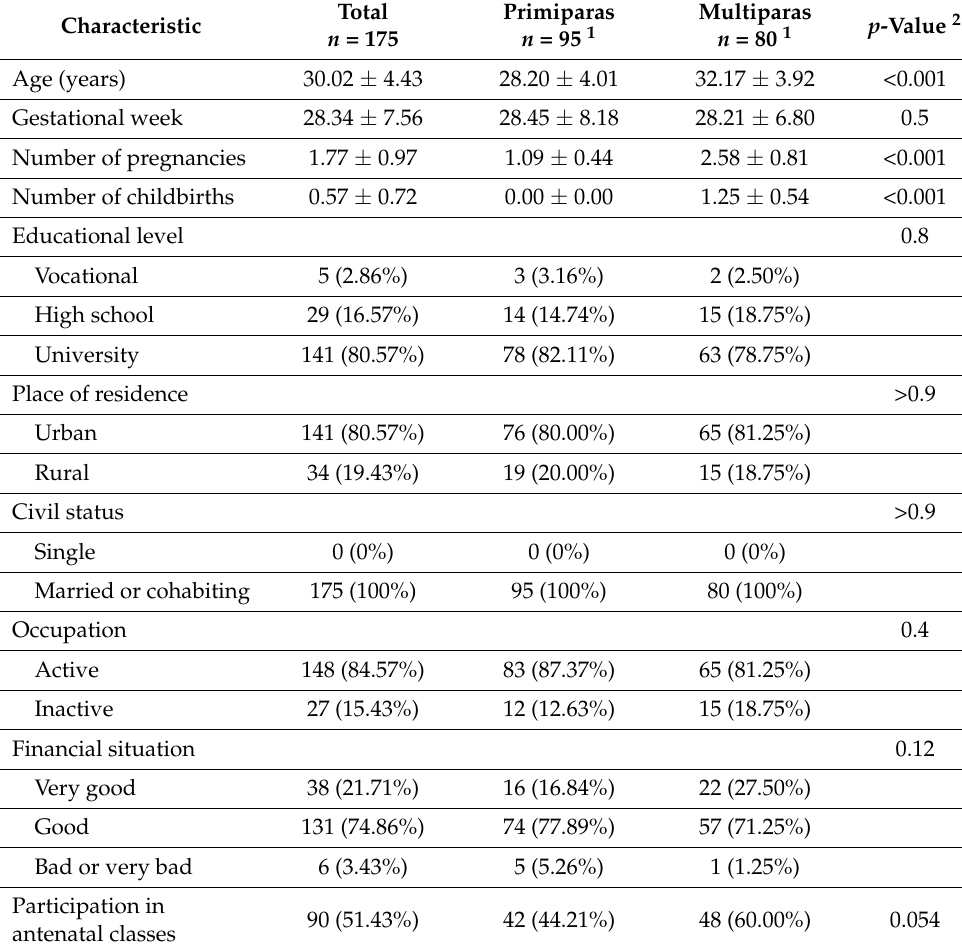
Table 1. Demographic and obstetric characteristics of the study